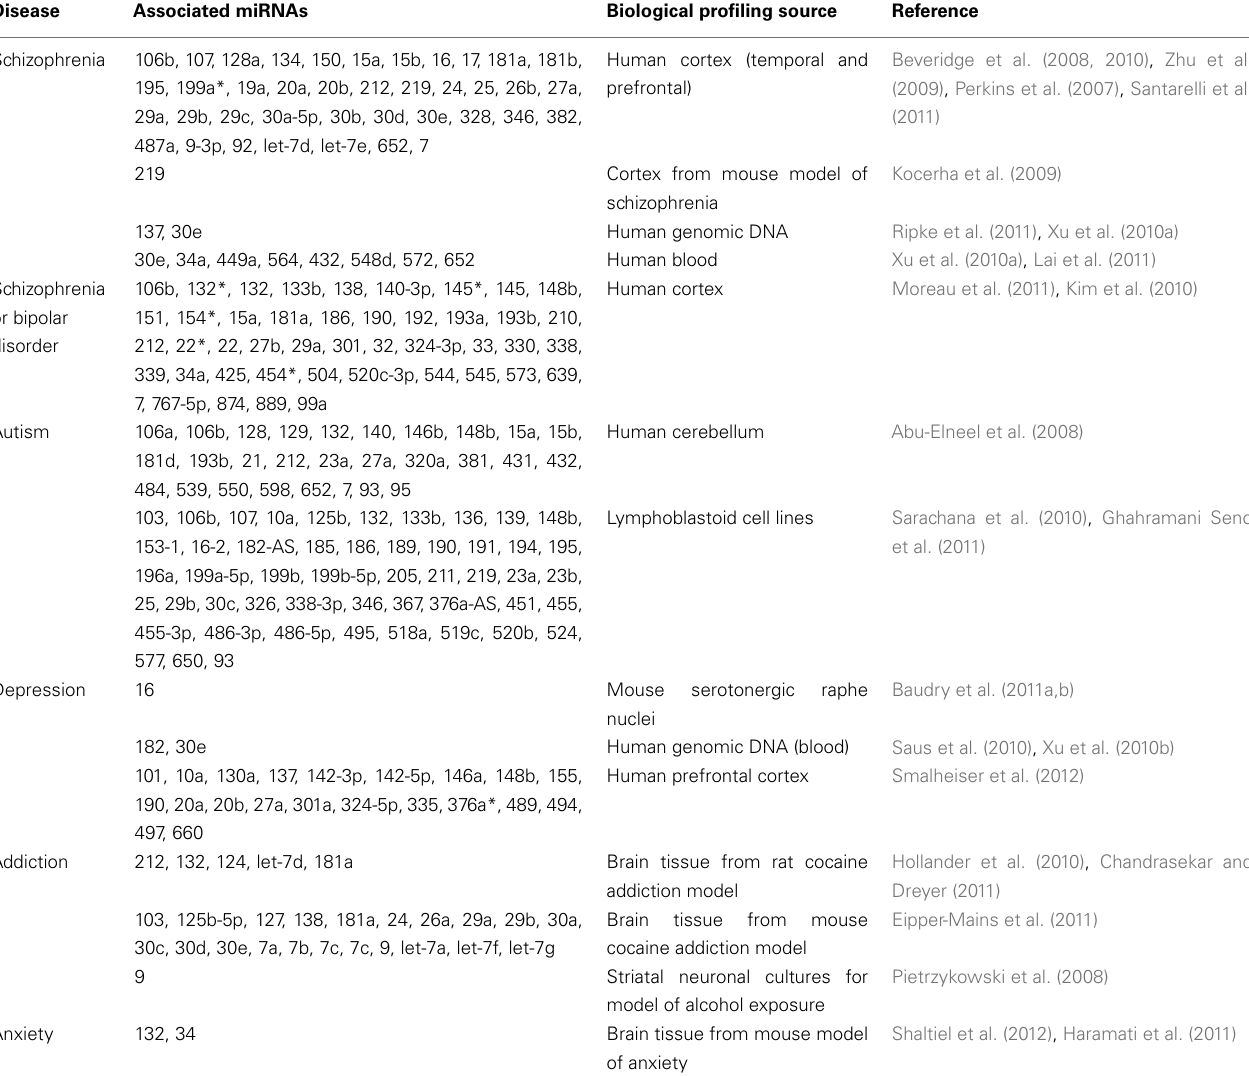
Table 1 | miRNAs associated with neuropsychiatric disease.